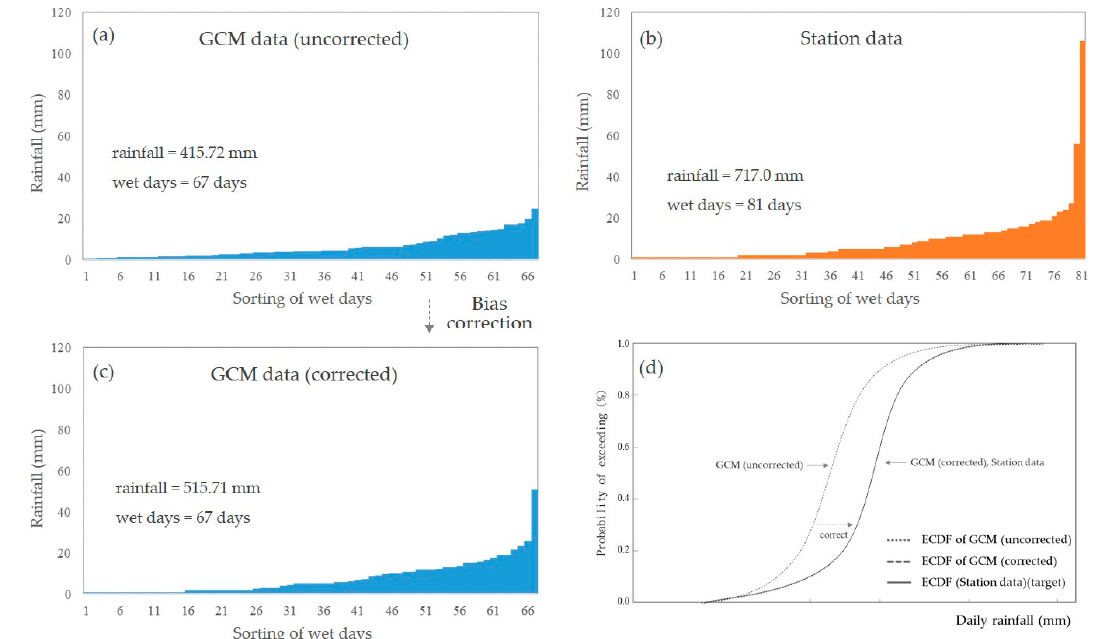
Figure 7. Example of quantile mapping bias correction and the bias of wet days. ( a ) demonstrates the sample of uncorrected GCM data in a certain month, ( b ) demonstrates the sample of station data in the same month, ( c ) demonstrates the sample of corrected GCM data in the same month, and ( d ) shows the correction process of ECDF of sample data. The bias correction corrects GCM data from ( a – c ), by considering the ECDF characteristic of station data ( b ). The bias correction makes the ECDF of GCM data corrected to match the ECDF of station data ( d ), therefore correcting the rainfall value, but the number of wet days is still unchanged.